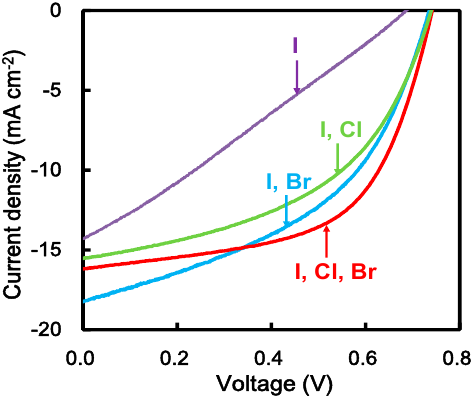
Figure 2. J ‐ V Characteristics of fluorine ‐ doped tin ‐ oxide (FTO) FTO/TiO 2 /CH 3 NH 3 PbI 3 − x − y Br x Cl y /spiro ‐ Figure 2. J-V Characteristics of fluorine-doped tin-oxide (FTO) FTO/TiO 2 /CH 3 NH 3 PbI 3 ´ x ´ y Br x Cl y / OMeTAD/Au photovoltaic cells. spiro-OMeTAD/Au photovoltaic